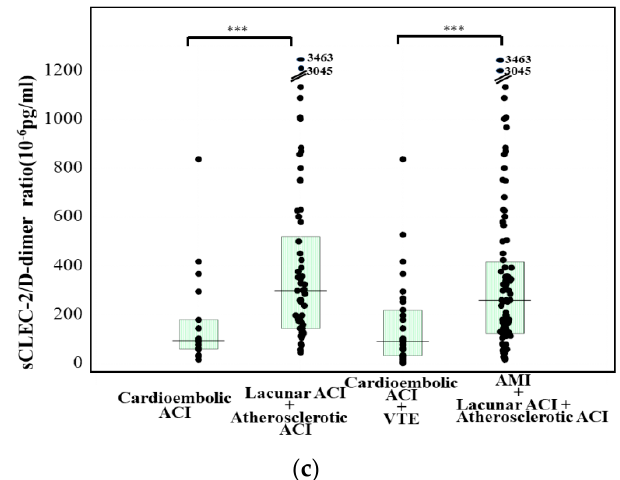
Figure 3. The plasma levels of sCLEC-2 ( a ), and D-dimer ( b ), and the sCLEC-2/D-dimer ratio ( c ) in patients with cardioembolic ACI, with atherosclerotic ACI and lacunar ACI, with cardioembolic ACI and VTE, or with AMI and atherosclerotic ACI and lacunar ACI. ACI, acute cerebral infarction; VTE, venous thromboembolism; AMI, acute myocardial infarction; *** p < 0.001; ** p < 0.01; * p < 0.05.